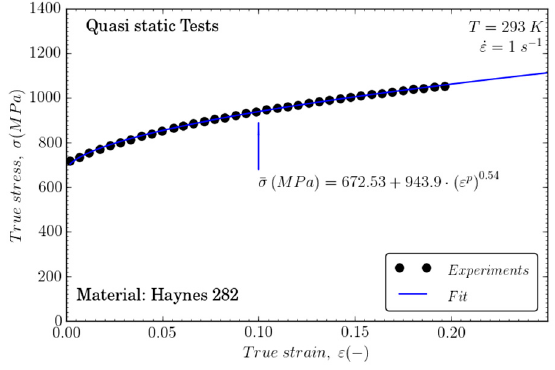
Figure 5. Flow stress evolution versus strain rate and fitting to obtain A , B , and n . Table 3. Parameters obtained for strain hardening-softening and comparison with Inconel 718 [22]. Material